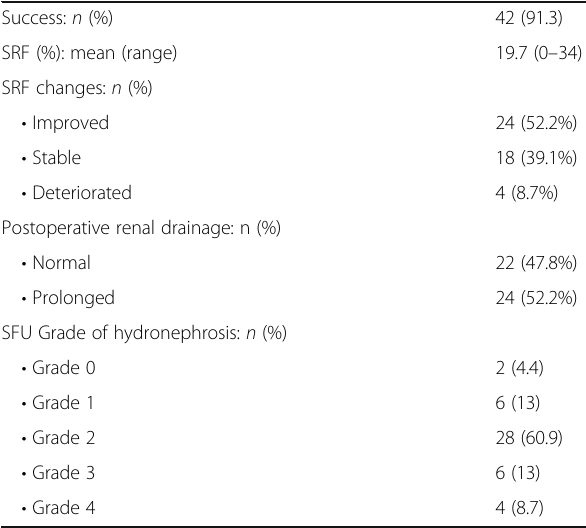
Table 2 Postoperative functional and morphological changes at